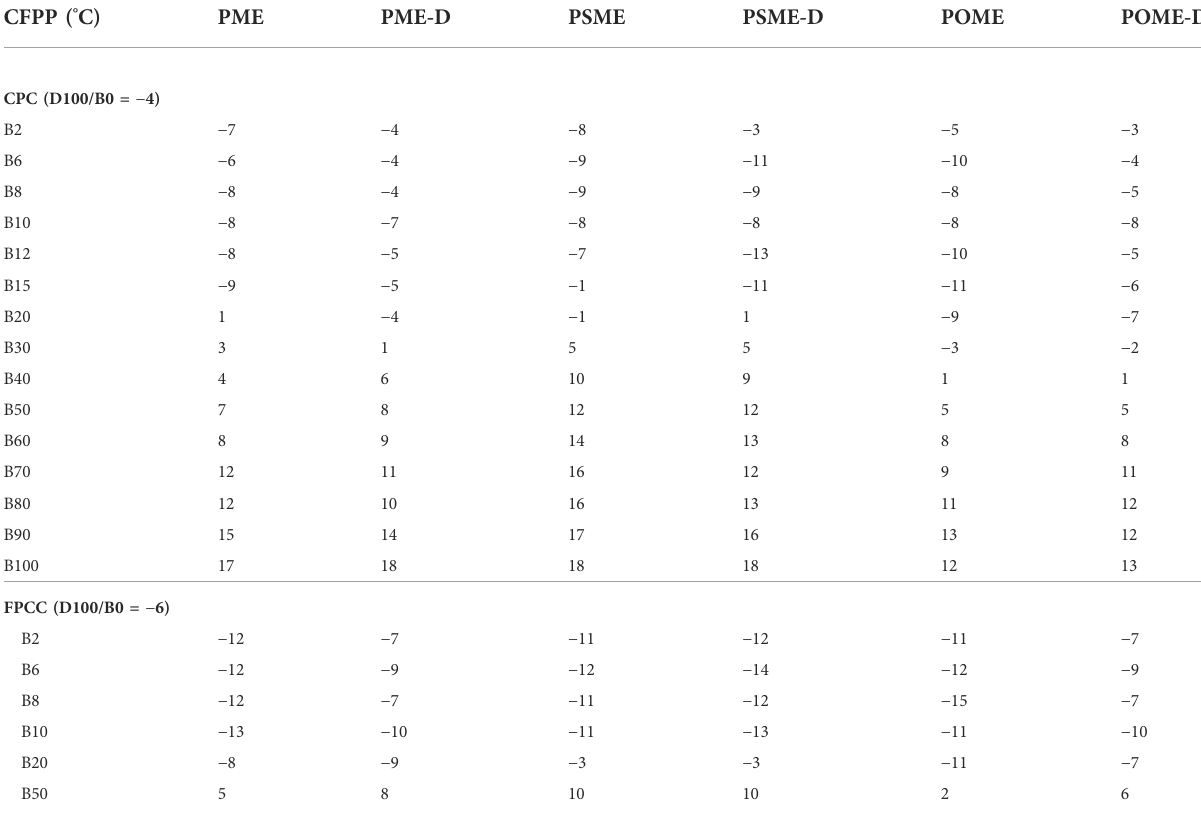
TABLE 3 CFPPs of distilled and non-distilled palm biodiesels with two major Taiwan diesels (CPC and FPCC) at various blending ratios. CFPP ( °